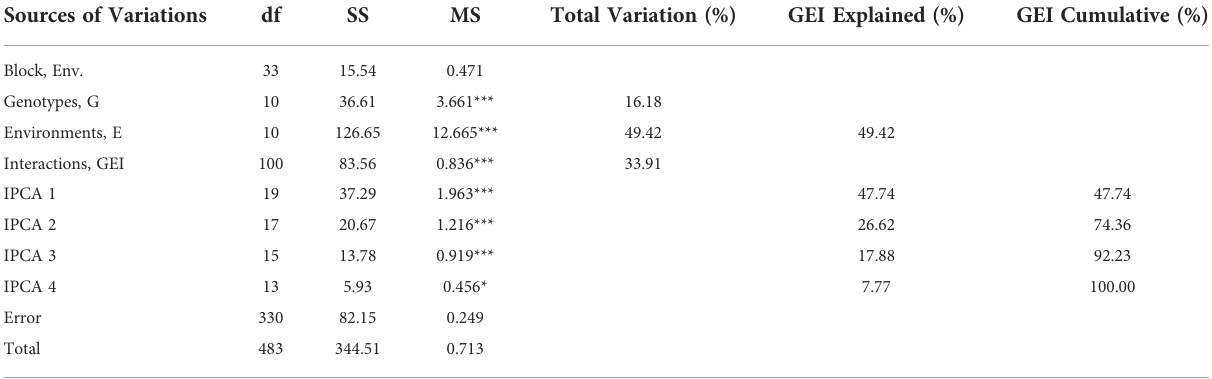
TABLE 6 Grain yield AMMI investigation of variance across seven locations in eleven environments. Sources of Variations Block,